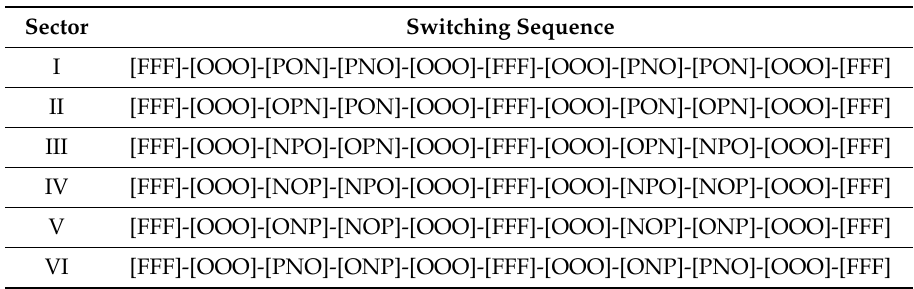
Table 3. Switching sequence and ST insertion of the proposed